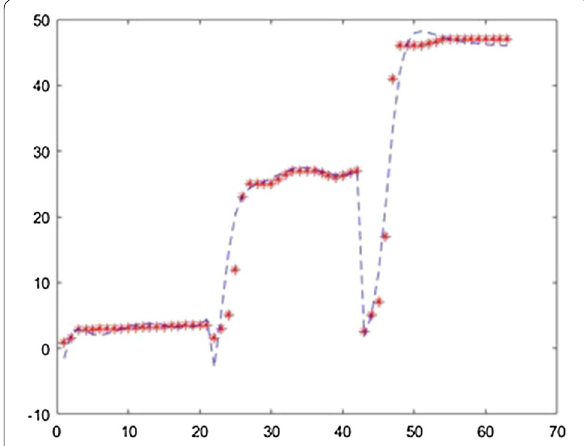
Fig. 8 Model results obtained with the Quasi‑Newton method